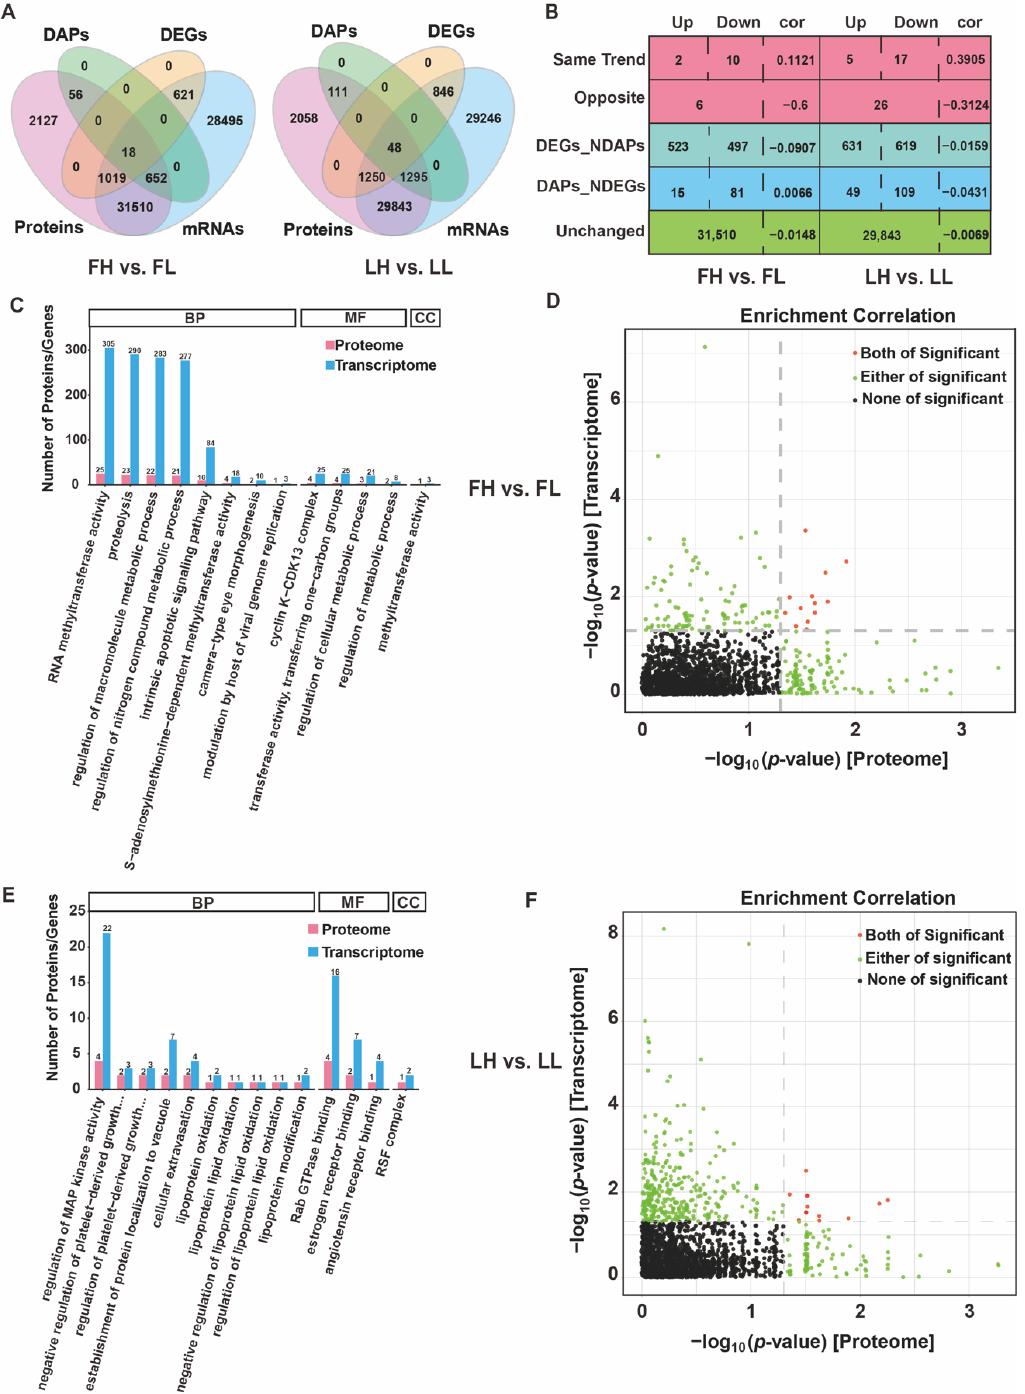
Figure 7. Conserved and differential regulation of genes and proteins expression in the oviduct. ( A ) Venn diagram regarding the proteins and genes that were abundant in the follicular and luteal phases. ( B ) Comparison of abundance ratios from transcriptomic and proteomic profiling in the follicular and luteal phases; cor represents Pearson correlation coefficient. GO enrichment analysis of DEGs correlated with proteomic data in the follicular ( C ) and luteal phase ( E ). GO terms enriched in the group of proteins that were significantly changed at both the mRNA and protein levels or proteins that were significantly changed at the mRNA or protein level in the follicular ( D ) and luteal phases ( F ).